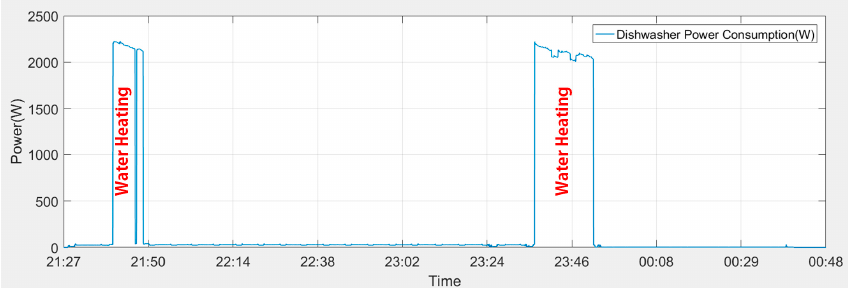
Figure 9. The power consumption of the dishwasher for the 55 °C economy program.